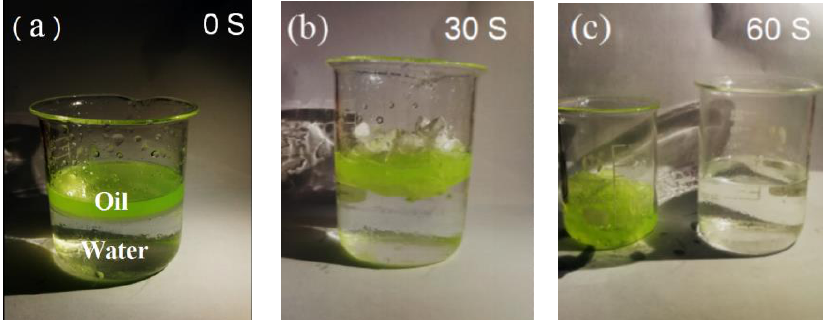
Figure 9. The absorption test was carried out in 60 s. ( a ) Ten grams of pump oil dyed in green were suspended on the top of 80 mL water. ( b ) Fiber membranes of 0.5 g in weight were fixed to adsorb the oils in the suspension. The images were taken after 30 s. ( c ) After 60 s, the oil absorption was almost complete, and the adsorbed fiber films were moved to another beaker.